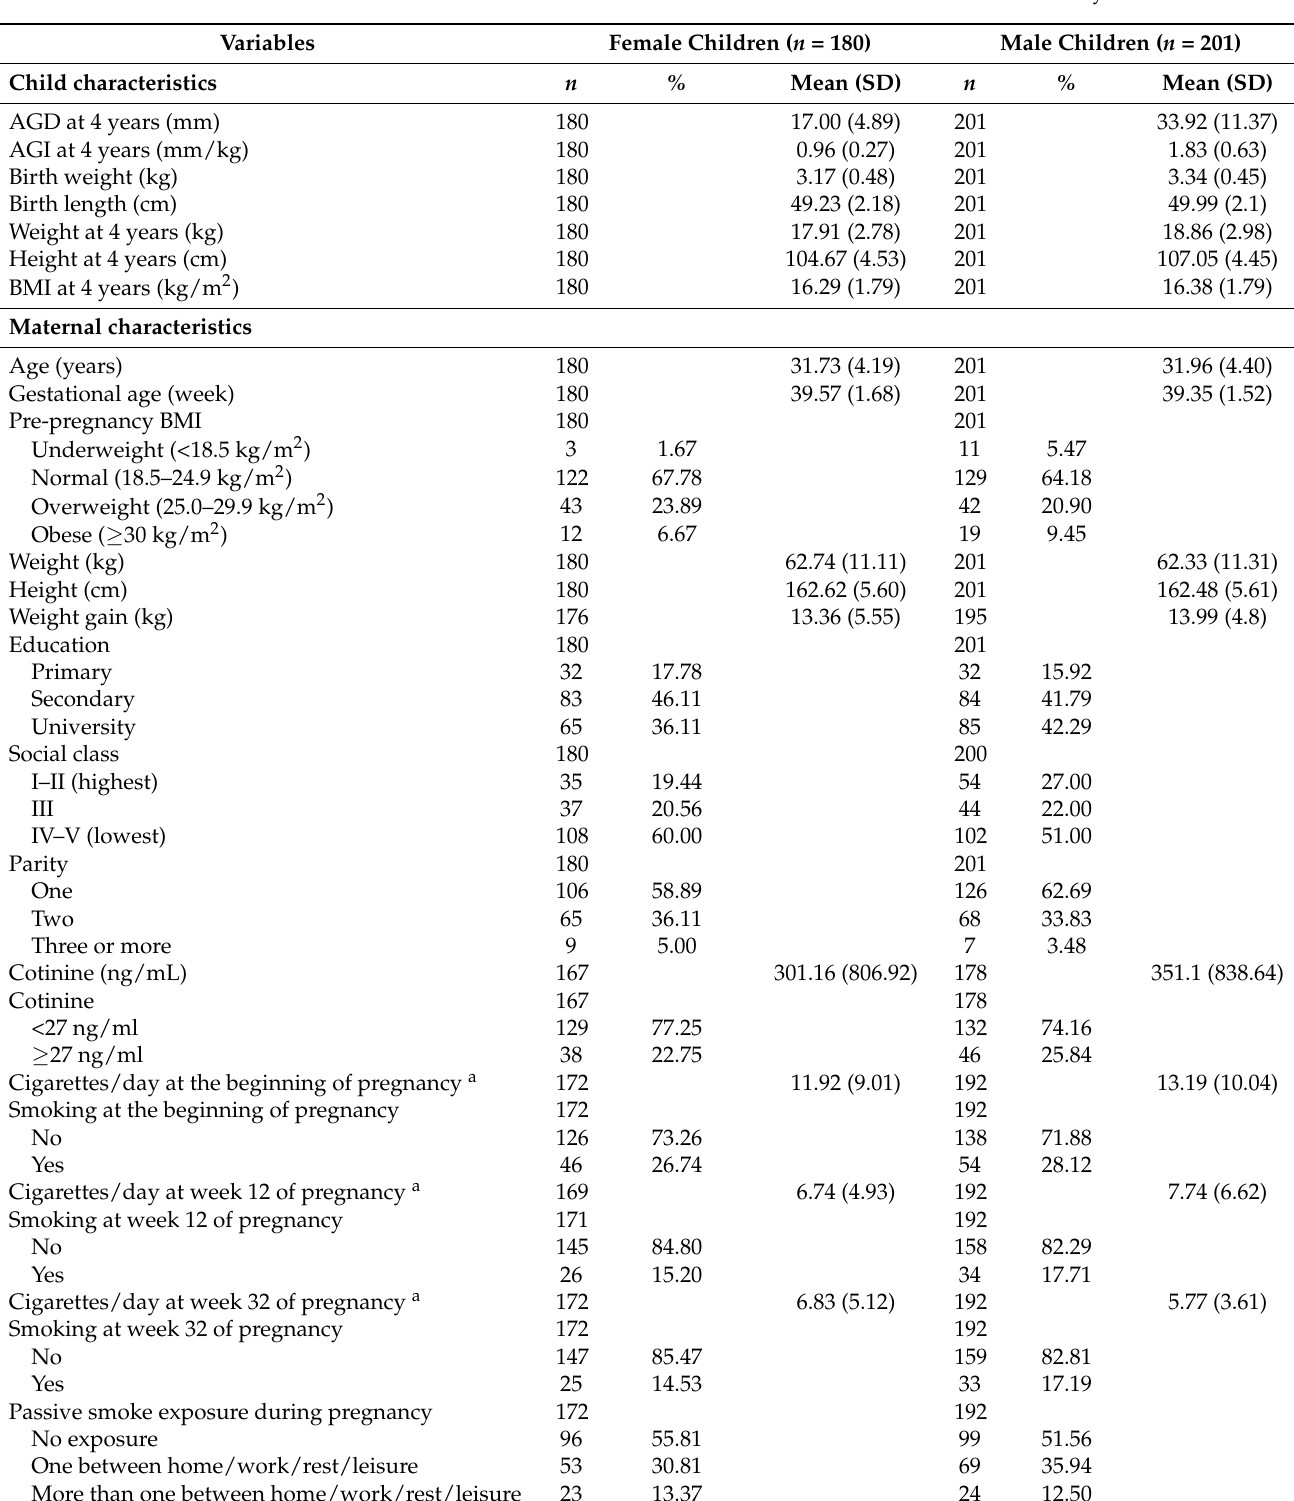
Table 1. Characteristics of mothers and children enrolled in the INMA-Asturias cohort